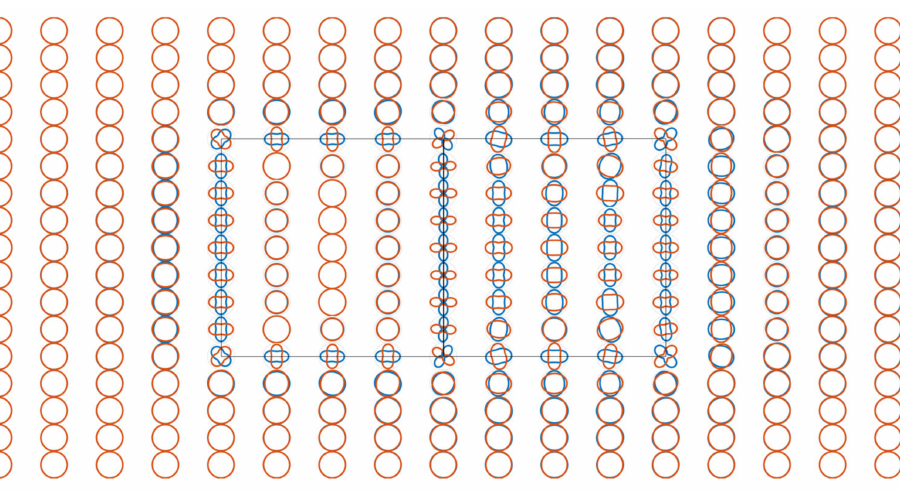
Figure 18. Polar plots of COMMEMI 3D-2A model for a frequency of 0.1 Hz.